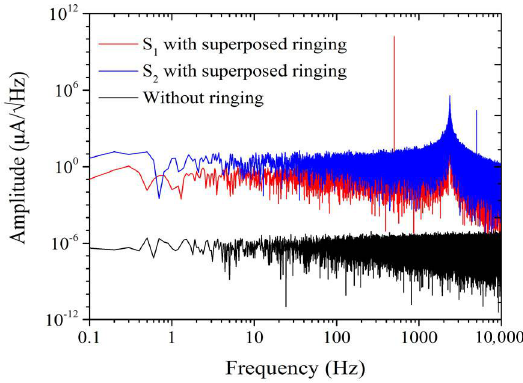
Figure 5. The simulated noise level with and without ringing.